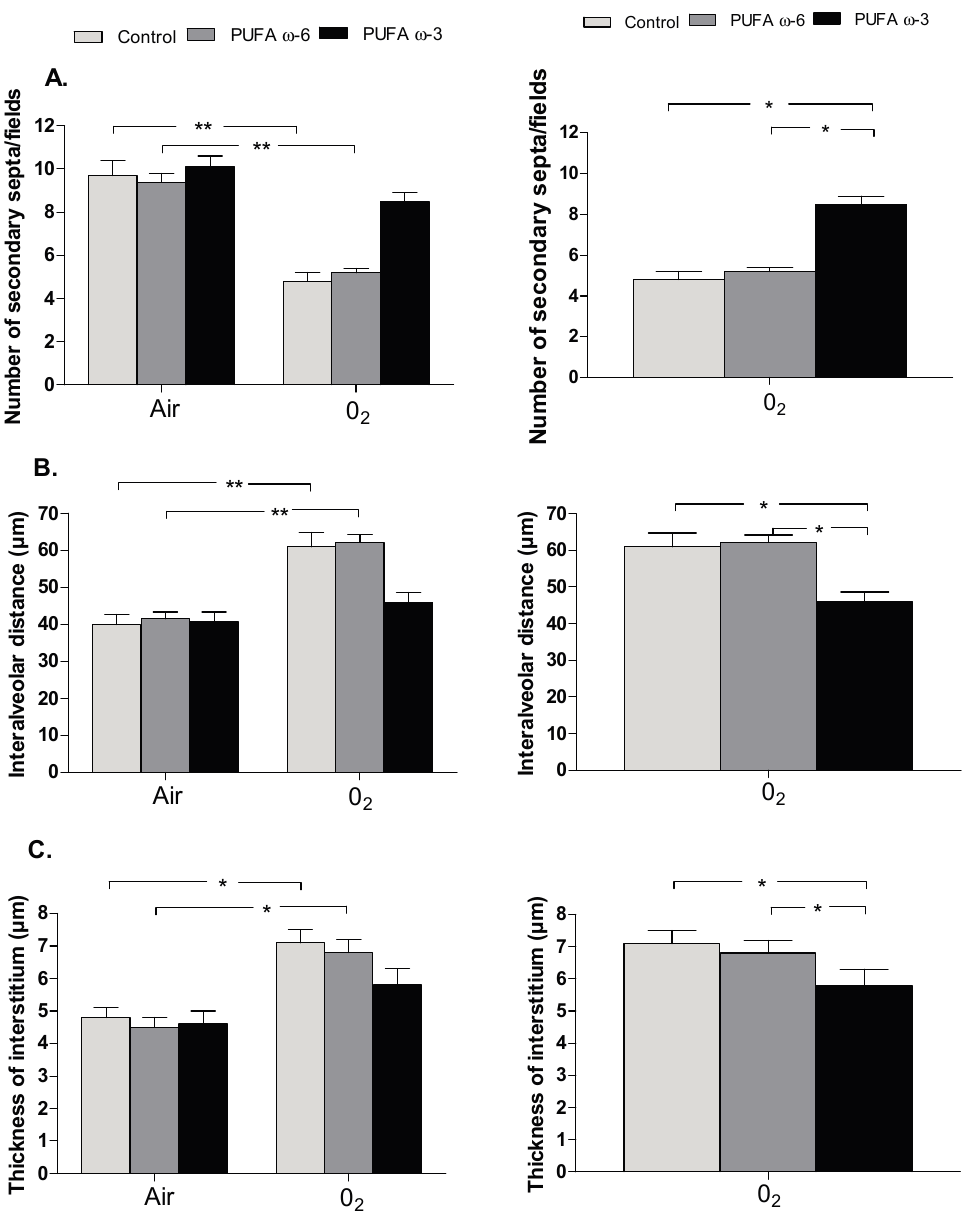
Figure 4. Lung morphometry, including the number of secondary septa/fields ( A ); the interalveolar distance ( B ); and the thickness of the interstitium ( C ). Value are expressed as mean ± SEM ( n = 30 in PUFA ω -6/air, PUFA ω -3/air, PUFA ω -6/O 2 and PUFA ω -3/O 2 and n = 10 in control/air and control/O 2 ). SEM: standard error of the mean; ** p < 0.01 and * p <